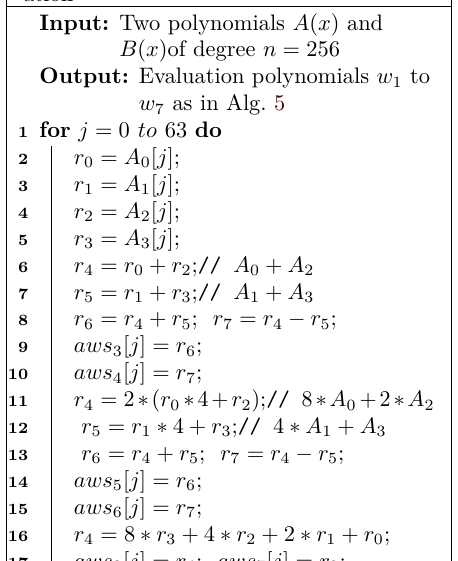
Algorithm 6: Toom-Cook 4-way evalu- Algorithm 7: Toom-Cook 4-way